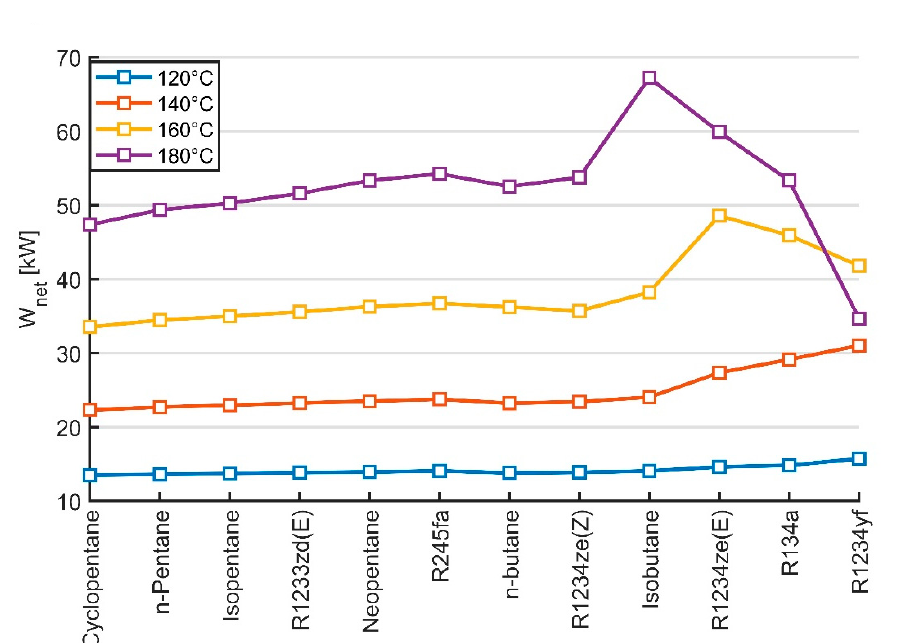
Figure 3. The net power output of the SORC configuration, as a function of the working fluids, for the geothermal heat source characteristic temperatures.